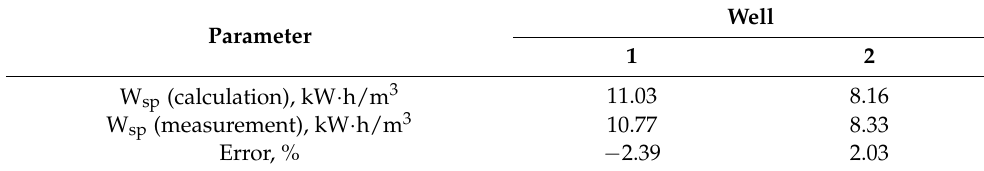
Table 4. Model accuracy estimation.